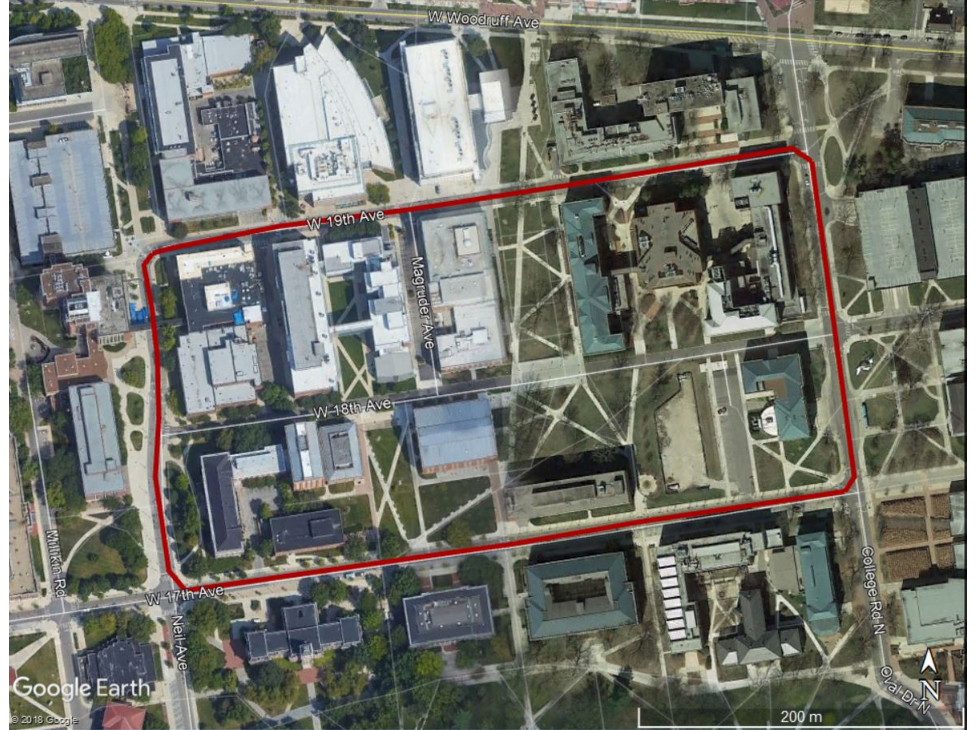
Figure 3. Test area (red line shows the GPSVan